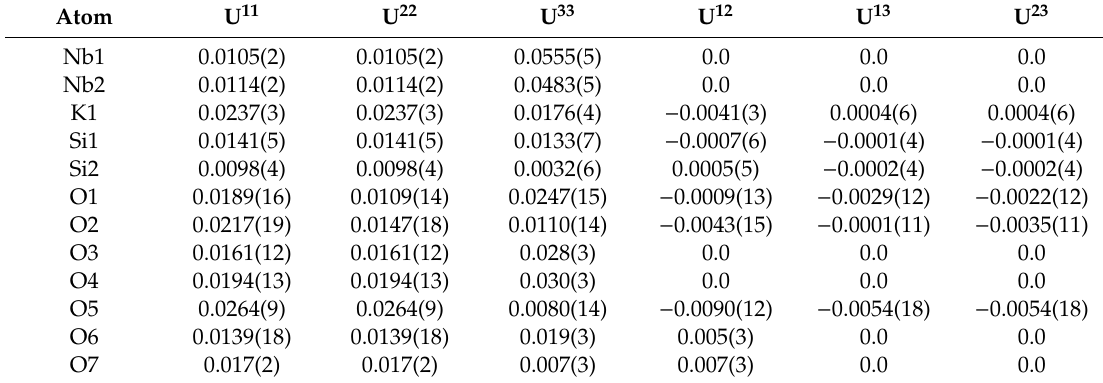
Table 8. Anisotropic displacement parameters (Å 2 ) for rippite.